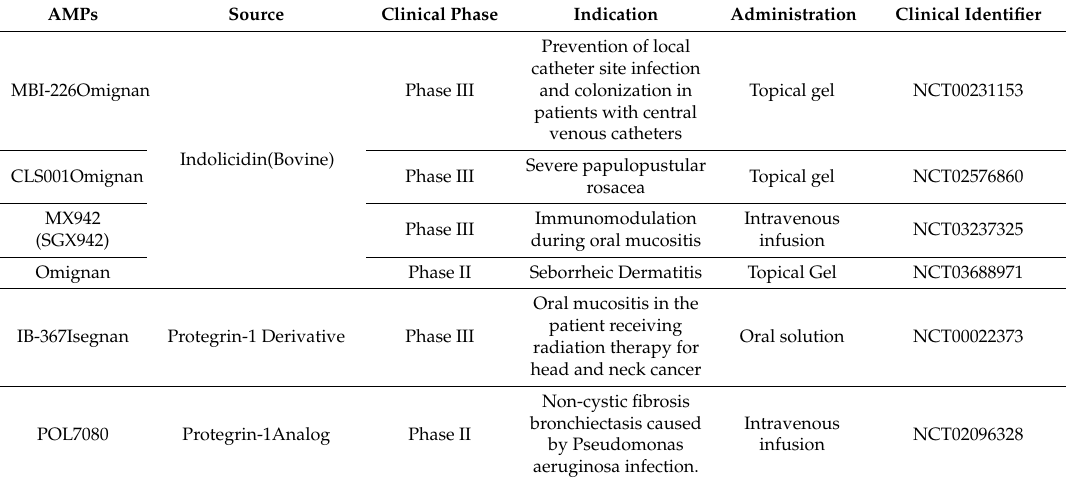
Table 2. AMPs of farm animal origin in clinical